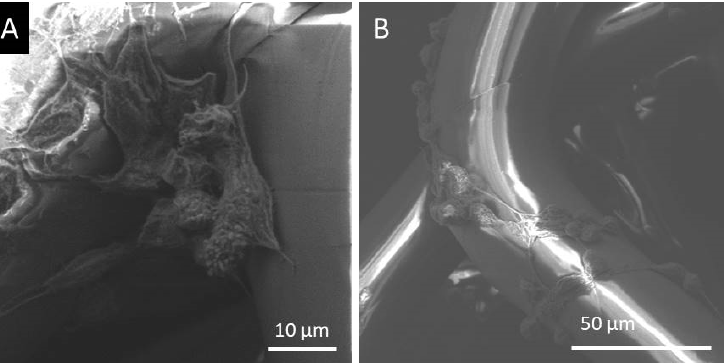
Figure 8. SEM images of the spherical structure of the LSCs cultured on the PLA/gelatin scaffolds, the ( A ) scale of 10 μ m and ( B ) scale of 50 μ m. In the design of an ideal tissue engineering scaffold, one needs to consider the suit- able fluid absorption ability of the material since extremely high water uptake will de- stroy its structure, while lack of it will inhibit cell growth [51]. The absorption ability of the scaffold is represented by its swelling percentage Sw (%), directly related to its hy- drophilicity or the material’s water content, which equals up to 80% in the corneal tissue [52–54]. On the other hand, the biodegradability of the scaffold is extremely important for new tissue generation, and it must maintain adequate mechanical integrity for proper damaged tissue recovery. The degradation rate should also be optimal and meet the ex- tracellular matrix cells’ secretion in order for the scaffold to be replaced by the new tissue [55,56]. In our study, the absorption ability of the scaffolds increased with the modifica- tion of the melt electrospun PLA with silk fibroin and gelatin-coating (Figure 9). The same trend was observed for both days 3 and 7 after incubation. The highest Sw was calculated for the PLA/gelatin scaffolds, and it was almost 60% on day 3 (the increase was from 26.98 ± 10.45% to 58.00 ± 27.91%. After 24 h, the scaffolds retained their structure, with no signs of PLA hydrolysis. Similar results were reported in the case of PLA/hydroxyl apatite (HA) scaffolds, where the HA drastically improved water absorp- tion from 65.2 to 159.3% [51]. In the current study, the scaffolds showed reduced swelling percentage at day 7, which can be explained by the gradual removal of silk fibroin and gelatin in saline solution. Since PLA is insoluble in water, biodegradation is very low, below 5% on days 3 and 7 after incubation. Both PLA/silk fibroin and PLA/gelatin scaffolds showed a considerable increase in weight loss compared to the single PLA, which was up to 36.31 ± 11.29% and 12.49 ± 1.10% on day 7, respectively (Figure 10). The results were expected since silk fibroin powder is partially soluble in water, and its solubility increases with the increase in temperature, while gelatin is soluble in hot water.